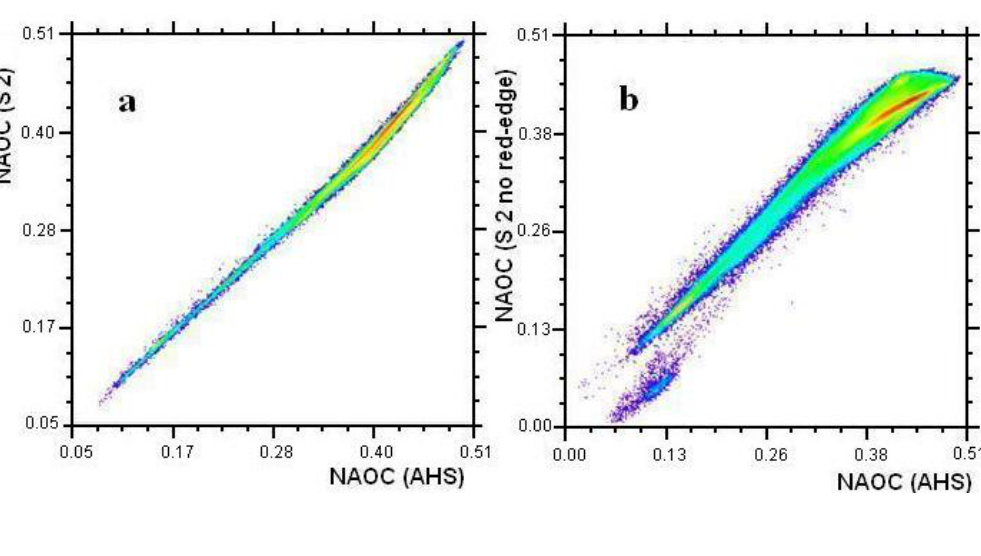
NAOC calculated without red-edge bands against AHS-based NAOC; (c) S2-based Ch*LAI against AHS-based Ch*LAI; and (d) S2-based Ch*LAI calculated without red-edge bands against AHS-based Ch*LAI. The colour scale indicates pixel